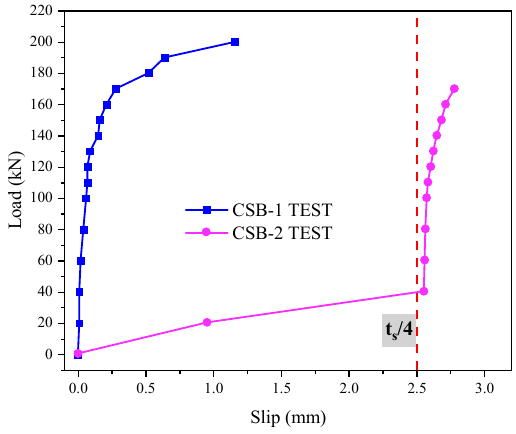
Figure 6. Load–slip curves.